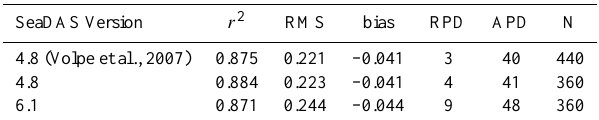
Table 5. Basic statistical quantities as obtained using both the cur- rent operational SeaDAS version (6.1) and the version 4.8 for Sea- WiFS. First row shows the statistics as provided in Table 4 of Volpe et al. (2007); for consistency, r 2 , RMS and bias are calculated over log-transformed pairs of data. Only stations used by Volpe et al. (2007) are used for this cross-comparison. Second and third rows show the same statistics for all pairs of values, in which both the current (6.1) and the former (4.8) matchup datasets present valid data.